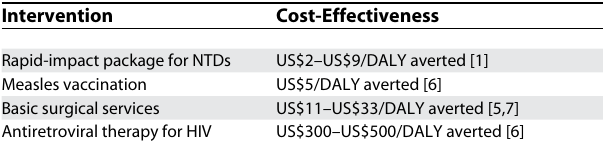
Table 1. Estimated Cost-Effectiveness of Health Interventions